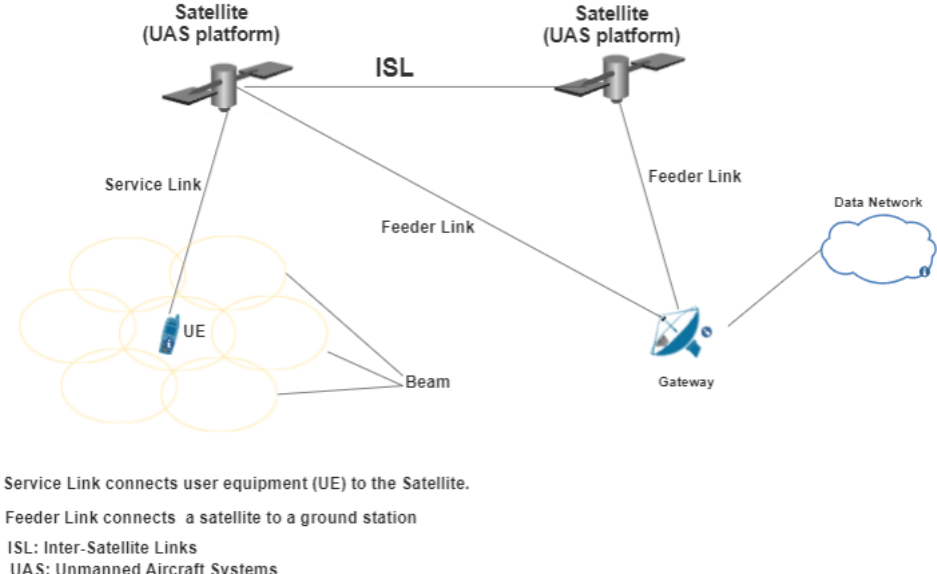
Figure 1. Non-terrestrial network typical scenario based on regenerative